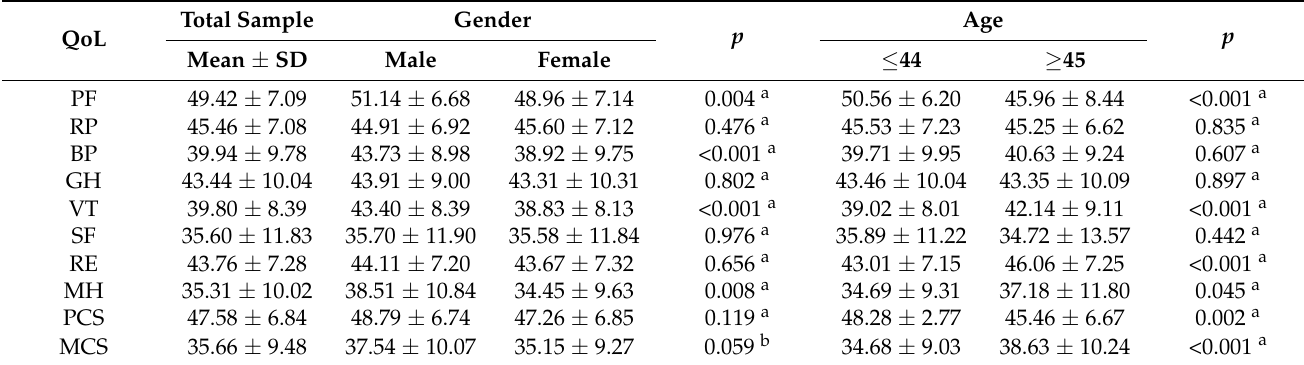
Table 3. Comparisons between median values of eight scales and mental and physical QoL components by SF-36 according to gender and age group.